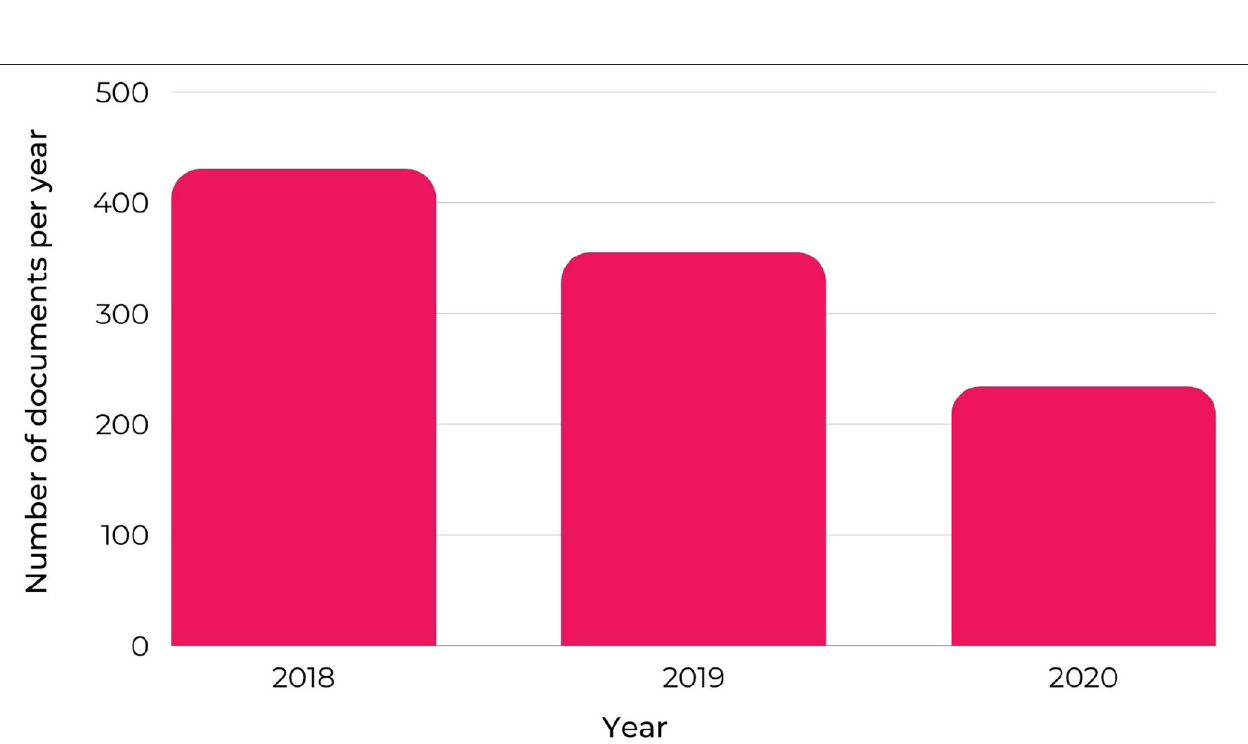
FIGURE 3 | Number of reports produced in Brazil per